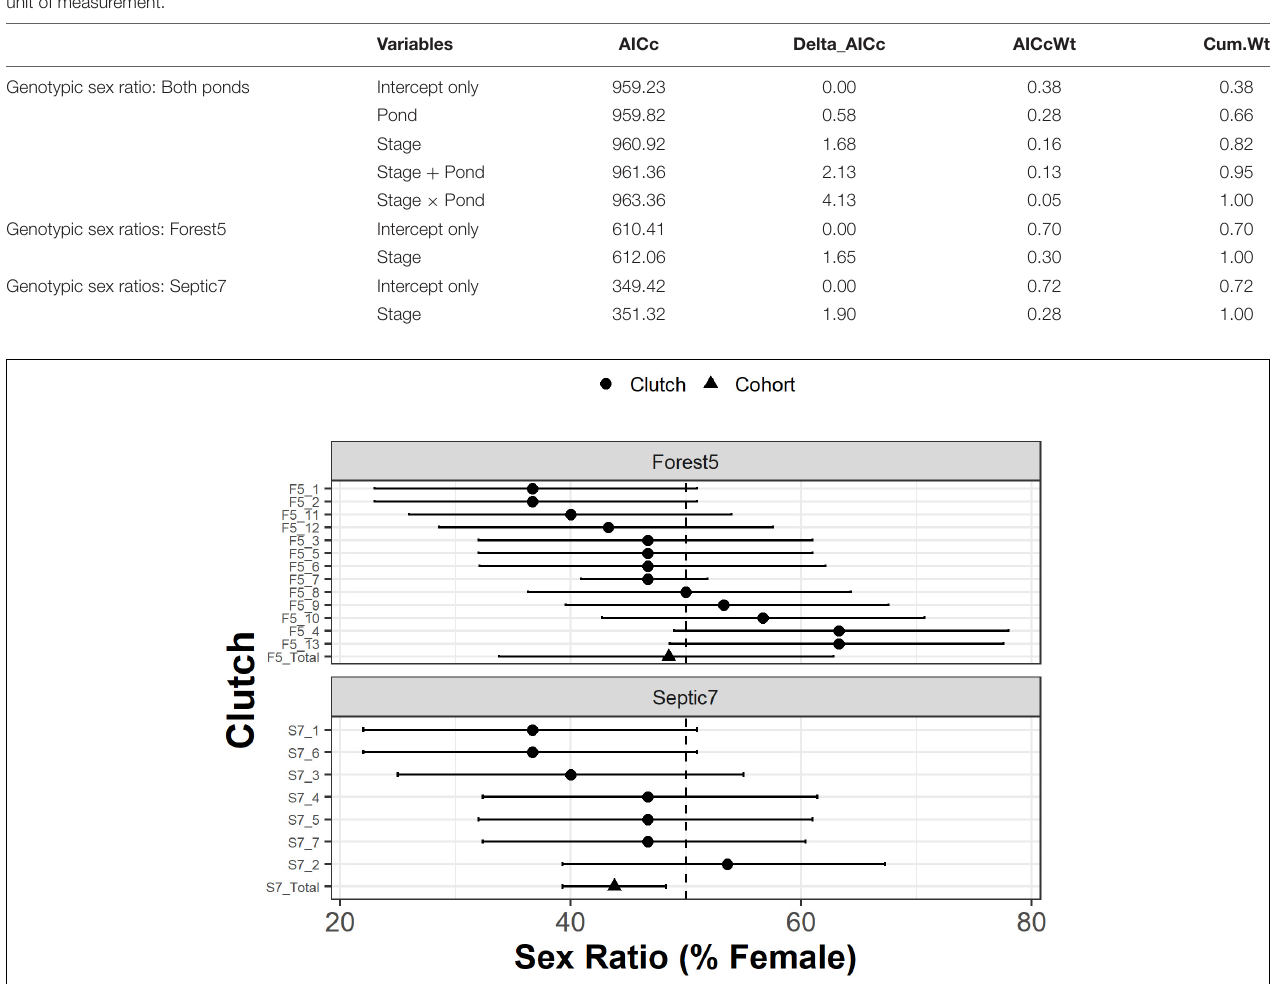
FIGURE 3 | Genotypic sex ratios for individual clutches (circles) in two R. clamitans populations. Clutch identifiers are on the y -axis. Cohort genotypic sex ratios (triangles) are pooled across clutches. The vertical dashed line indicates sex ratios at parity (50% female and 50% male). Horizontal bars are Bayesian credible intervals and higher support for biased sex ratios is observed in clutches with credible intervals that minimally overlap or do not overlap the vertical line at